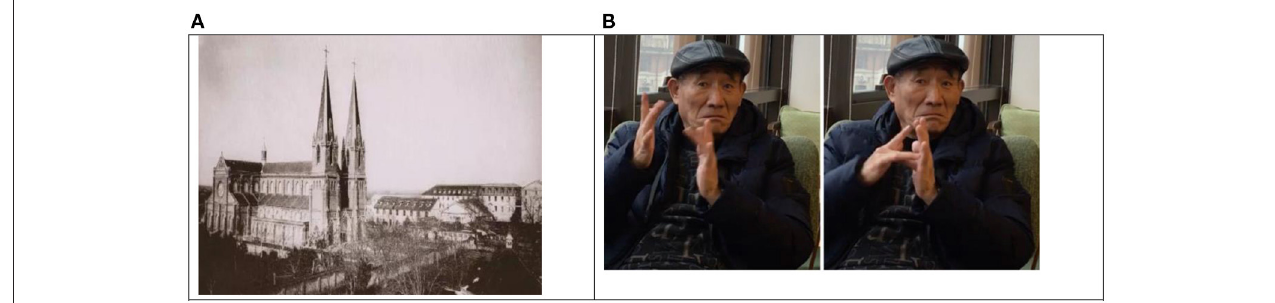
FIGURE 2 | (A) Xujiahui Cathedral in 1910 (left). (B) Sign place name XUJIAHUI (also a family name).